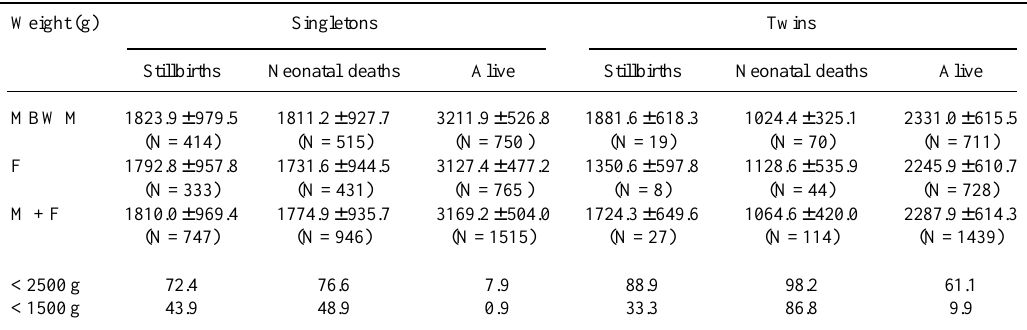
Table VI - Mean birth weight (MBW) in grams according to sex (M = males; F = females) and percentage of newborns with low (< 2500 g) and very low (< 1500 g) birth weight among singletons and twins. Weight (g)